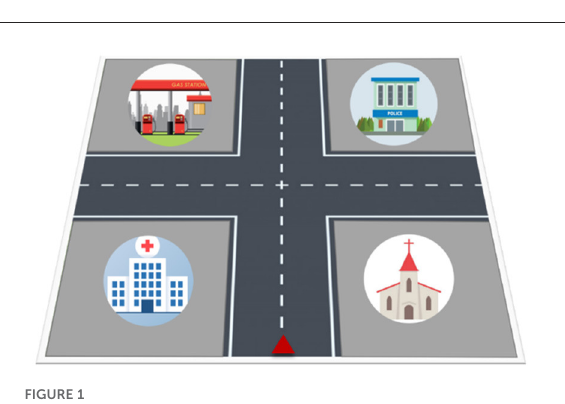
FIGURE1 Example of an intersection with four landmarks. Which of these landmarks would you use in a route description if the person has to turn left to reach her destination?